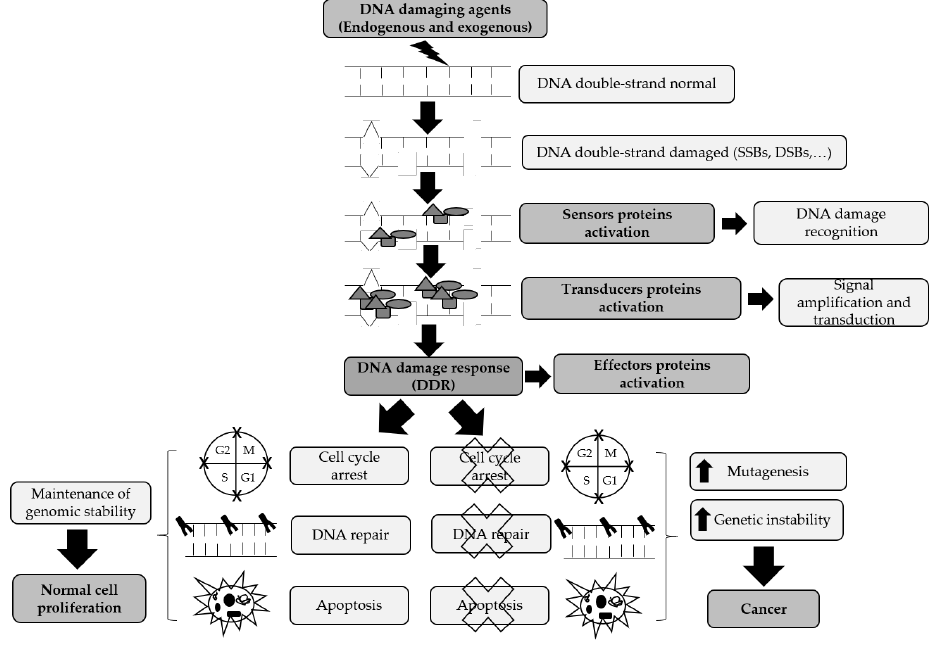
Figure 1. Organization and functional consequences of the DNA damage response (DDR). In DDR, different proteins act together to recognize the DNA damage (sensors), amplify and translate the DNA damage signal (transducers) and, consequently, stimulate an appropriate response (effectors). Several intrinsic mechanisms, including cell cycle checkpoints, DNA repair pathways, and apoptosis are activated to secure genomic stability maintenance and normal cell proliferation. However, when these mechanisms fail, DNA replication errors and aberrant chromosomal instability take place, culminating in increased mutagenesis and genomic instability and ultimately the promotion of cancer